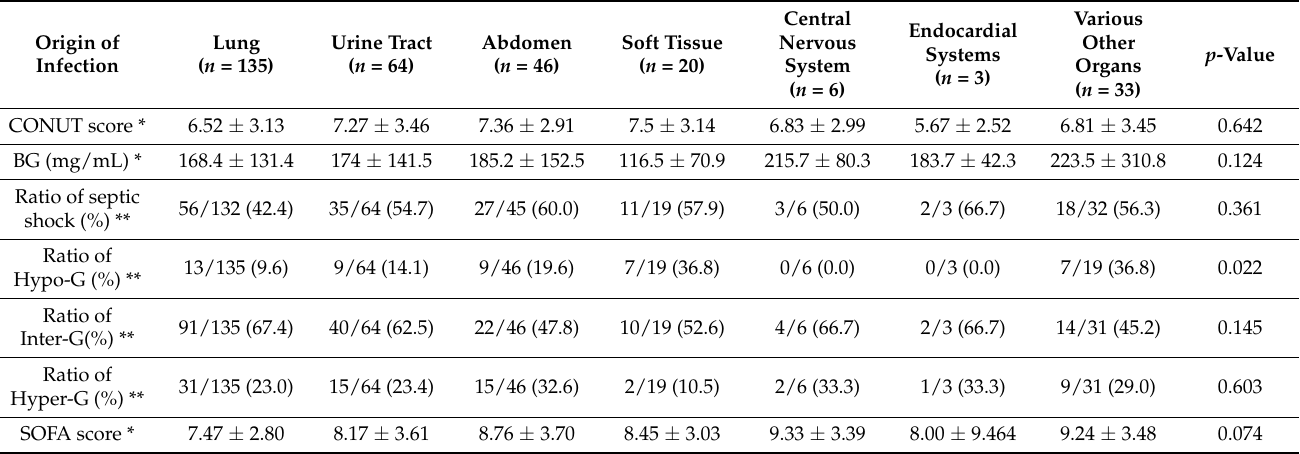
Table 2. Origin of infection in this study.